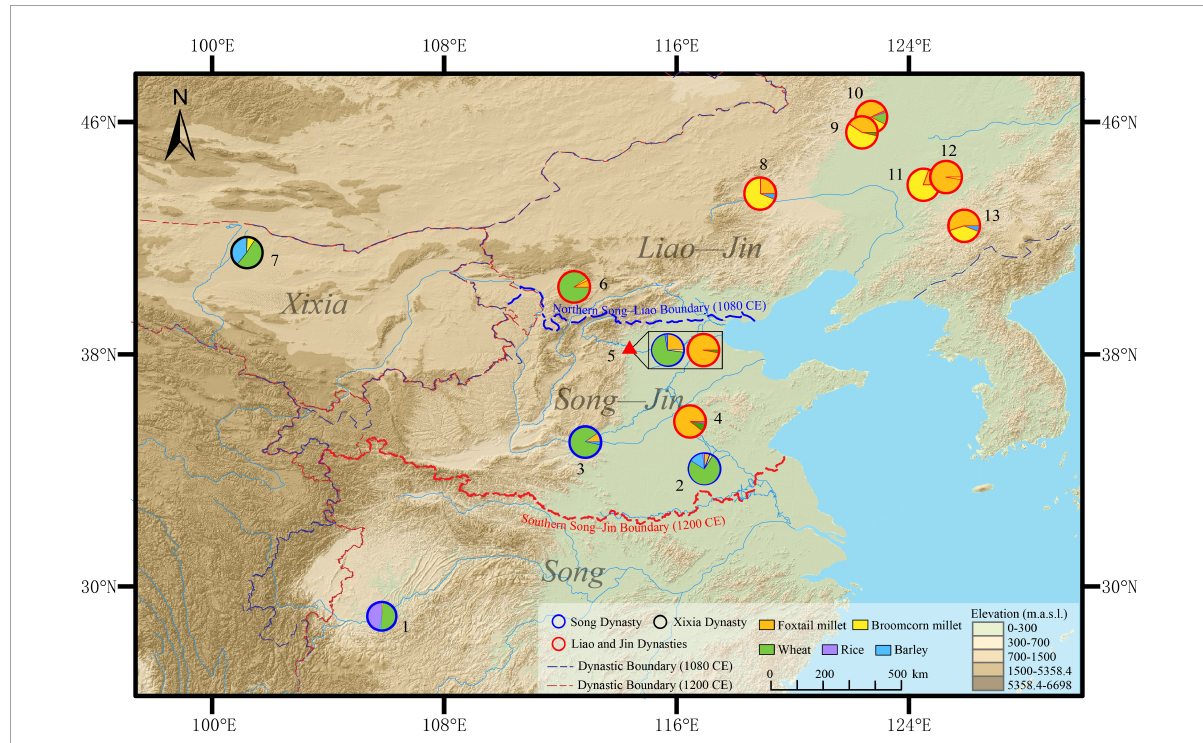
FIGURE6 Comparison of estimated actual yield proportions of ZKS and other sites: 1. Handong Cheng (Ma et al., 2020); 2. Oupanyao (Bai et al., 2017); 3. Xijincheng (Chen et al., 2010); 4. Liang Zhuang (Wu et al., 2010); 5. ZKS (this study); 6. Zhuangwocun (Zhao, 2020); 7. Heicheng (Shi et al., 2022); 8. Bayantala (Sun and Zhao, 2014); 9. Sun Changqing (Yang et al., 2010a); 10. Yongping (Yang, 2014a); 11. Changshan (Chen, 2019); 12. Lichunjiang (Yang et al., 2010b); 13. Luotongshancheng (Yang,